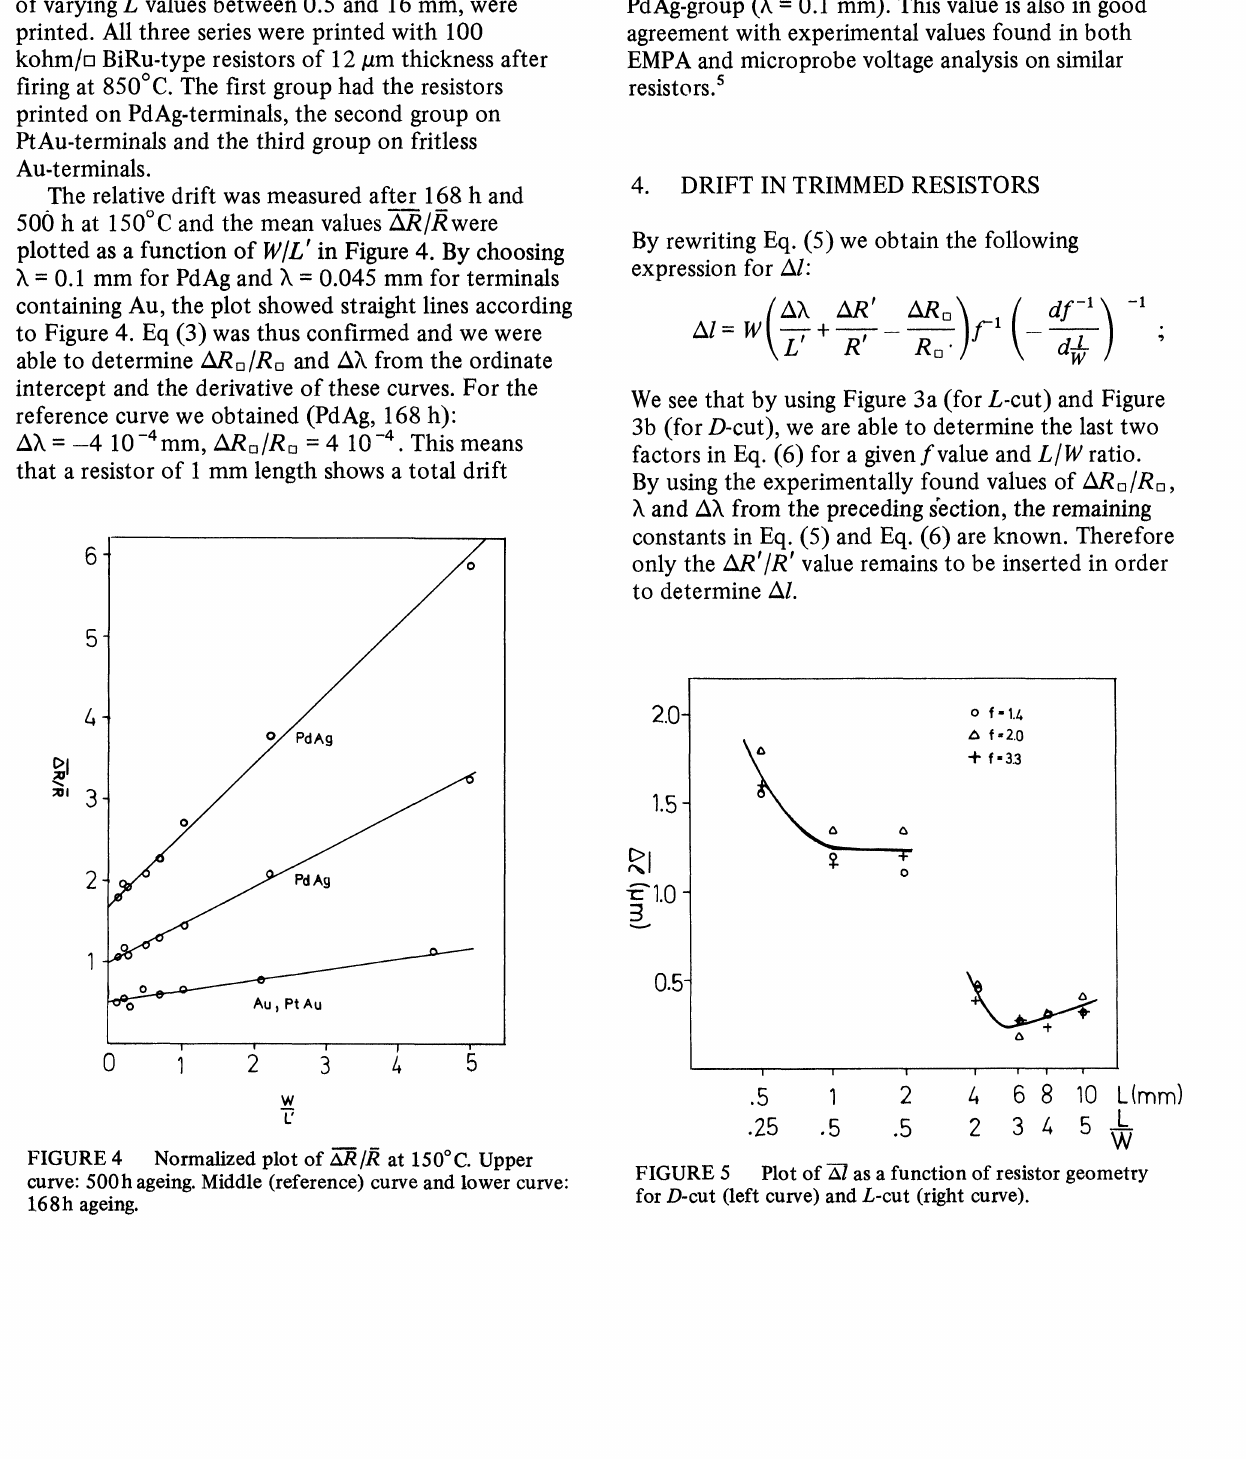
Normalized plot of zXR/R at 150C. Upper curve: 500 h ageing. Middle (reference) curve and lower curve: 168 h ageing.